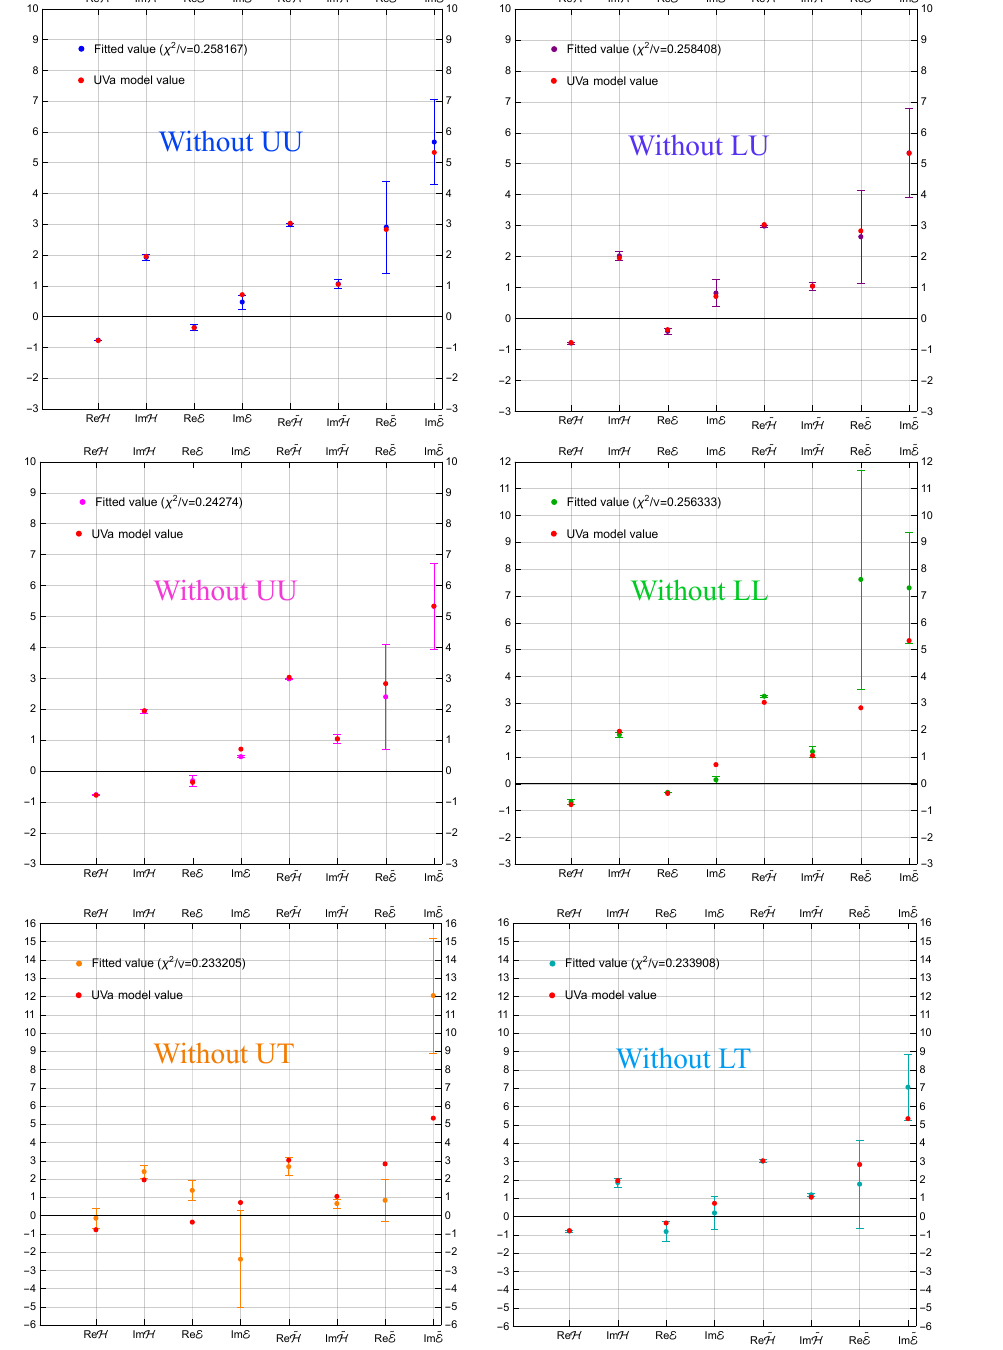
Figure 9. Comparison of the 8 extracted twist-2 CFFs with different cross section polarization data